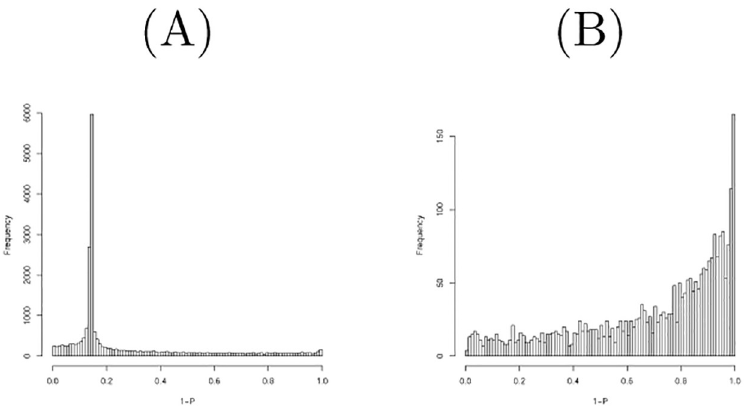
Fig 3. Histogram of raw P -values computed using the null distribution generated by shuffling when genes in the third data set were considered. (A) All genes (B) Top 2780 most expressive genes.